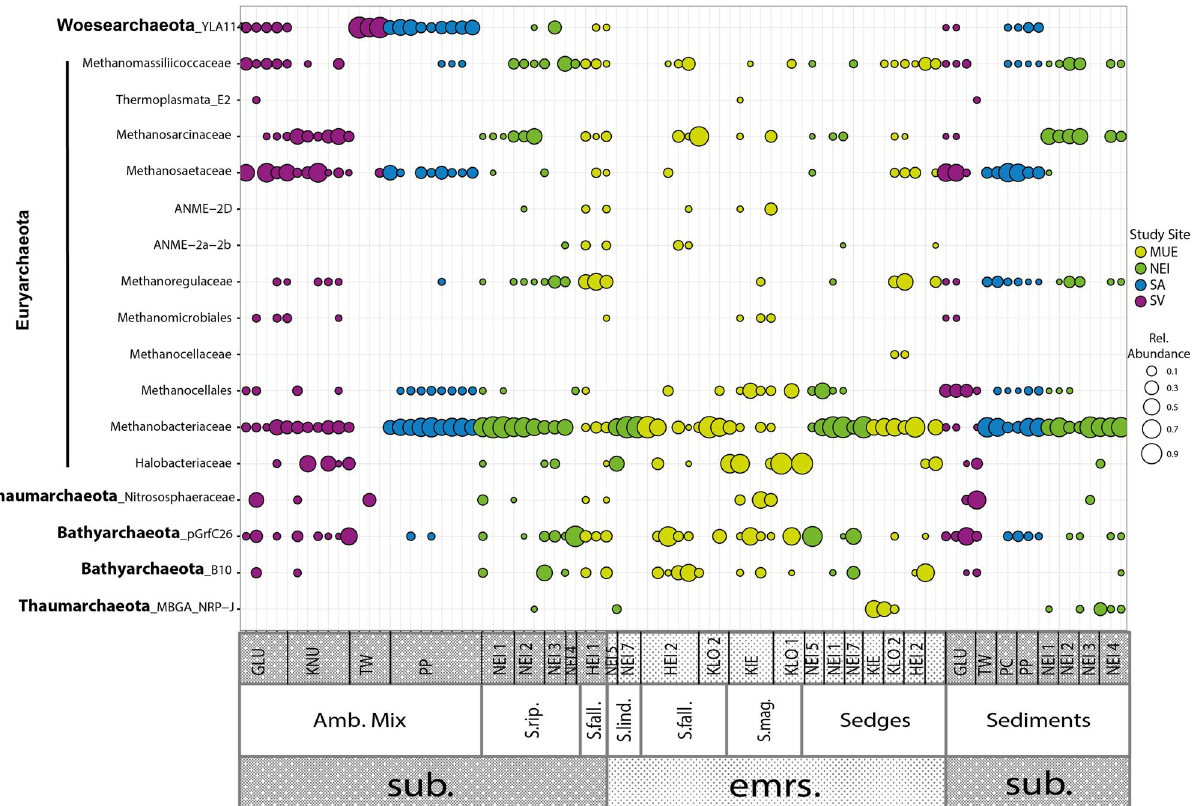
Figure 6. Overview of the relative abundances of archaeal families making up more than 0.5% of the total archaeal sequences in one or more 16S rRNA gene libraries. The sizes of the circles correspond to the relative abundances of the families. The colors indicate which region the samples originate from. MUE Mueritz national park; NEI Neiden, Northern Norway; SA Samoylov, Siberia; SV Svalbard, Norway. The samples are sorted by ecosystem types and latitude from left to right. sub. = submerged. emrs. = emerged/above the water table. Amb. Mix. = a mix of Amblystegiaceae . S. rip. = Sphagnum riparium . S. fall. = Sphagnum fallax. S. mag = Sphagnum magellanicum . S. lind. = Sphagnum lindbergii